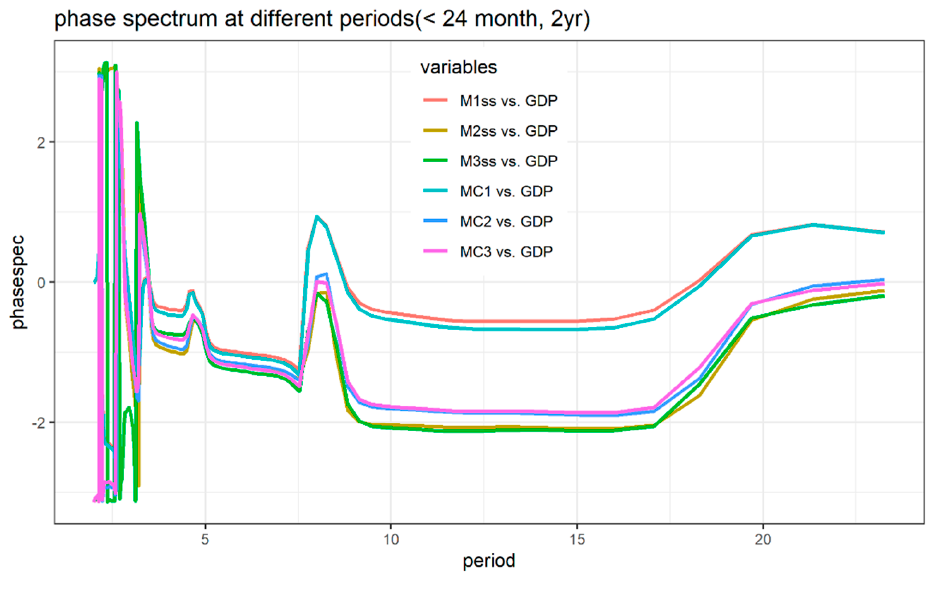
Figure 10. Phase differences with short periods.